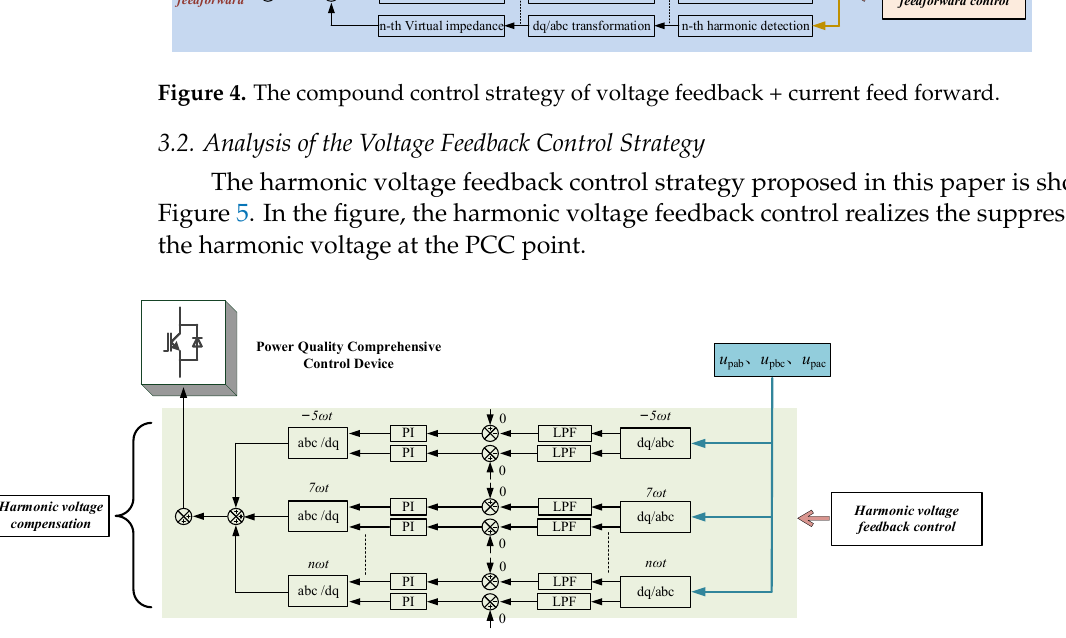
Figure 5. Voltage feedback control block diagram. The harmonic voltage feedback control loop proposed in this paper is mainly for rectifier bridge-type nonlinear loads, such as inverter air conditioners, energy-saving lamps and voltage-type inverters. The core of the control method is based on the fundamental wave control by adding the harmonic voltage loop control to achieve the purpose of 5, 7 and 11 harmonic suppression. Specifically, in order to achieve the purpose of 5th harmonic compensation, the first step is to transform the extracted 5th harmonic component into direct flow through − 5 ω t transformation, and then through low-pass filtering, the 5th harmonic compensation is achieved through PI control. The control principle of the remaining harmonics is the same. The theoretical derivation is as